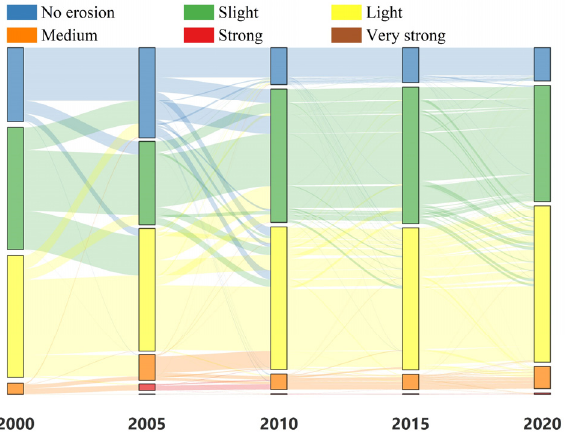
Figure 5. Soil erosion class